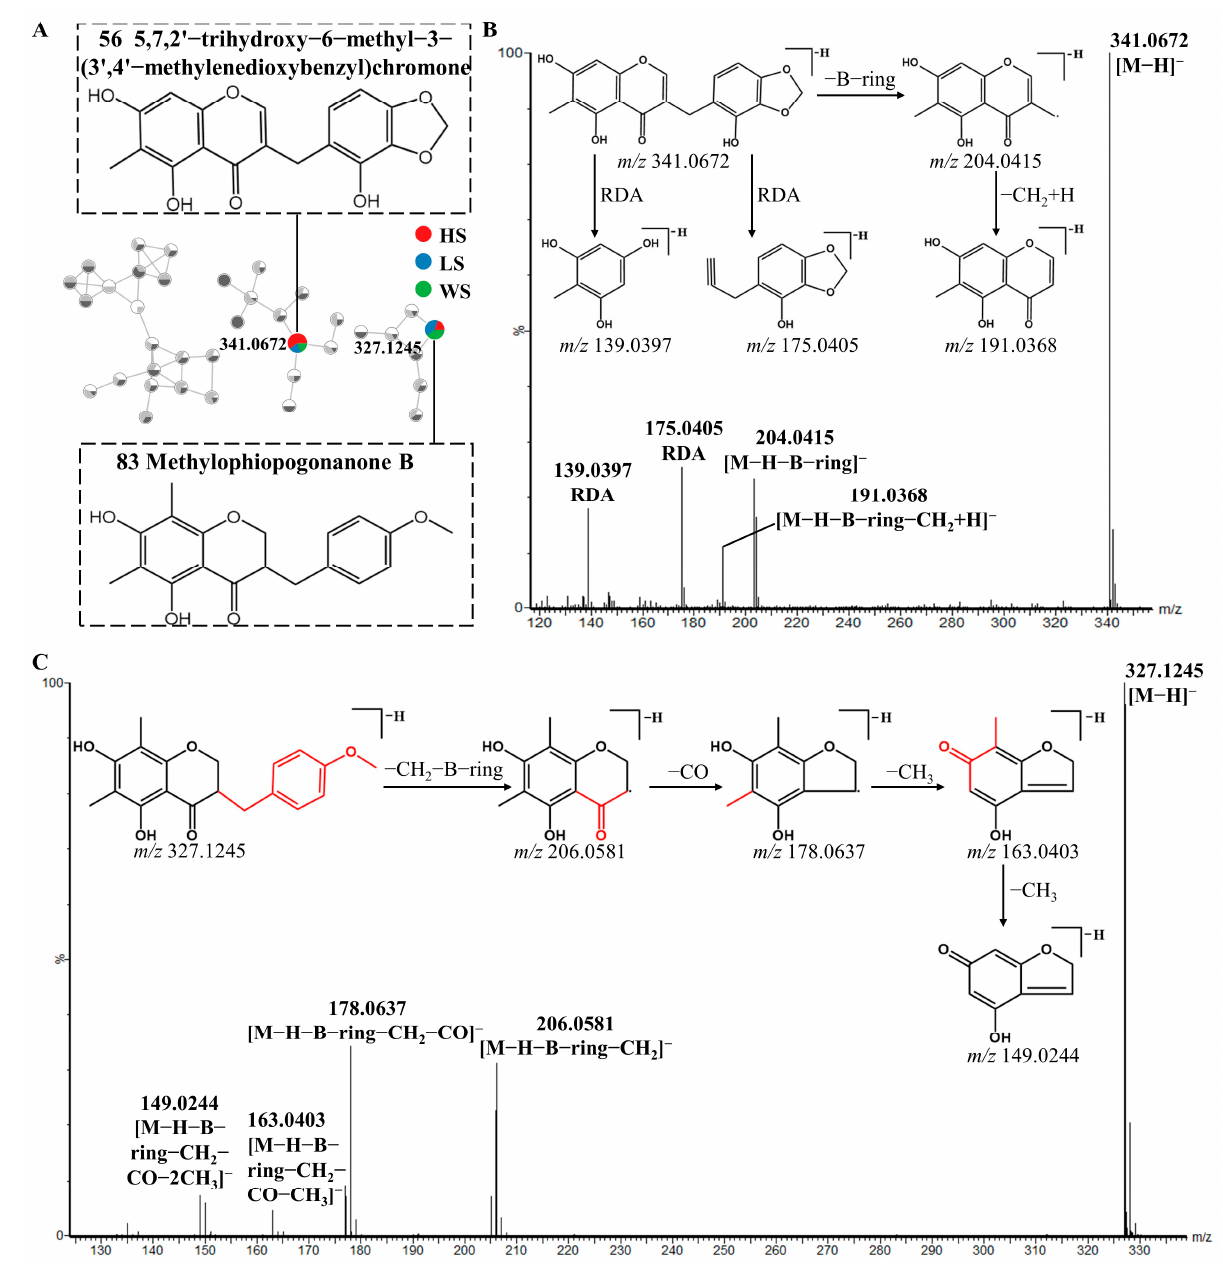
Figure 5. Possible fragmentation pathway of homoisoflavonoids: The enlargement of cluster Ⅲ molecular network ( A ), MS/MS spectra and fragmentation behaviors ( B , C ) of 5,7,2’-trihydroxy-6-methyl-3-(3’,4’-methylenedioxybenzyl) chromone (Compound 56 ) and Methylophiopogonanone B (Compound 83 ), respectively.